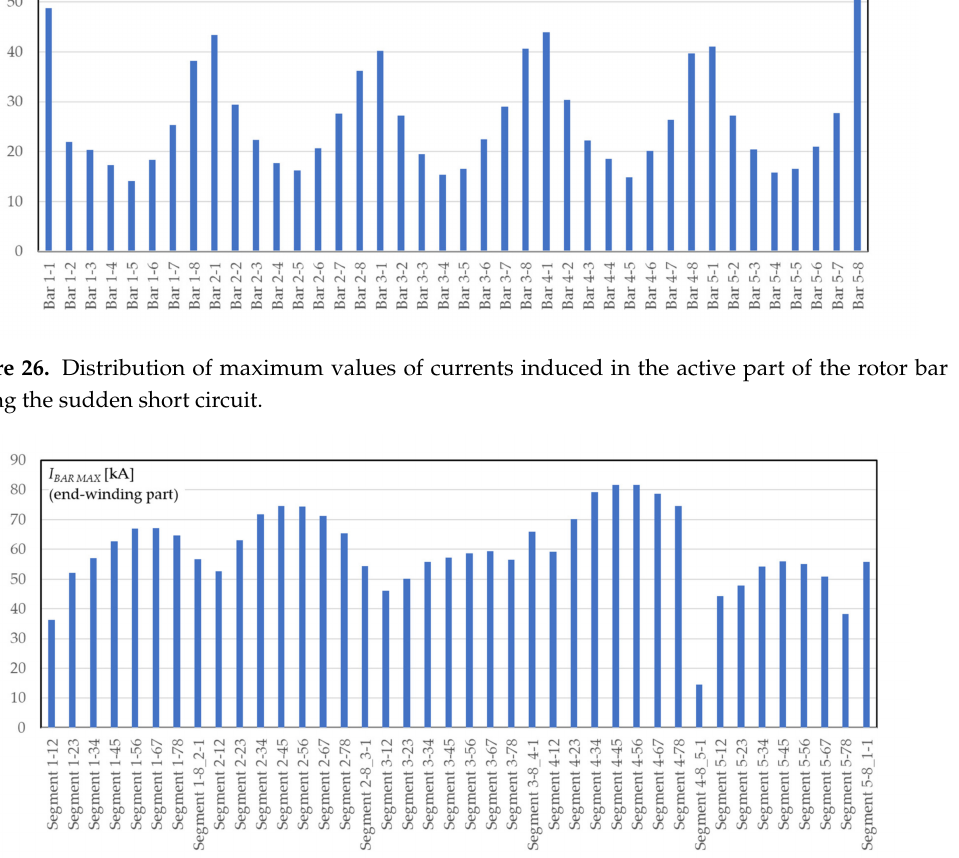
Figure 27. Distribution of maximum values of currents induced in the rotor’s circuited segments during the sudden short circuit.